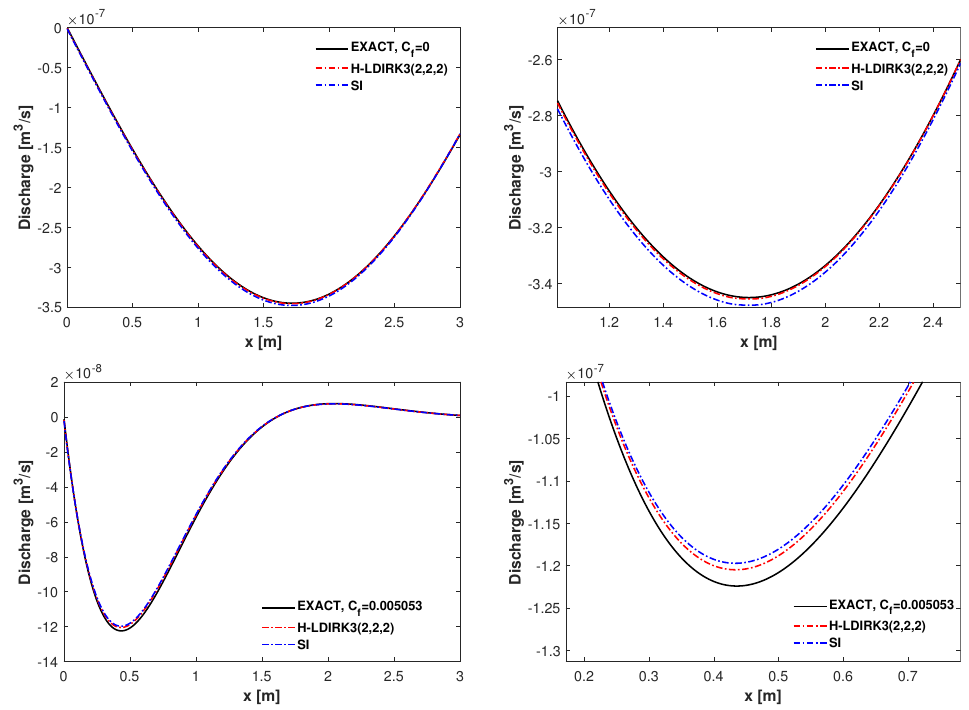
Figure 4. Example-3: Numerical solutions of the wave damping at t = 25 s with C f = 0 ( top ) and C f = 0.005053 ( bottom ) and the corresponding enlarged views. The friction term has been treated with either the H-LDIRK3(2,2,2) method or the SI